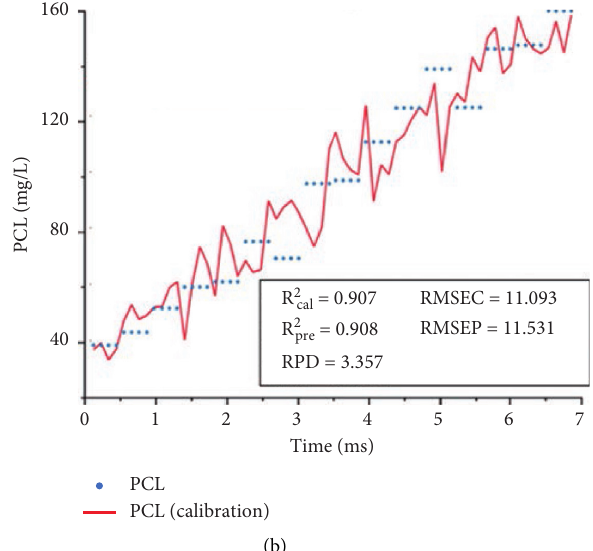
Figure 7: (a) Correlation coefficients between each characteristic wavenumber and their response to the content of phycocyanin content in liquid (PCL); (b) least squares support vector machine (LSSVM) modeling process of characteristic peaks detected by the 405nm portable Raman spectrometer